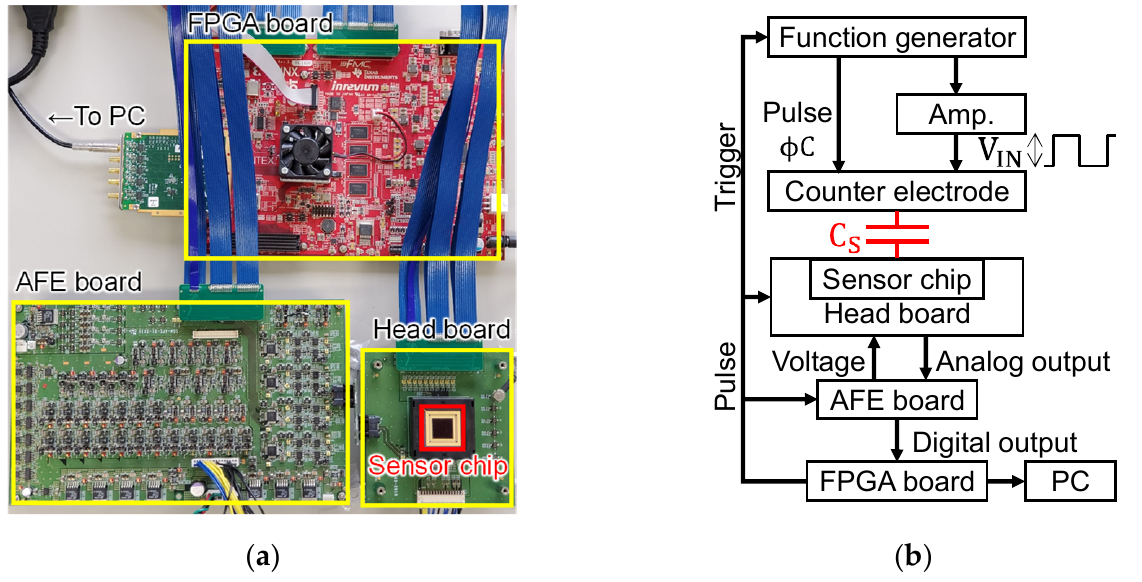
Figure 7. The measurement system for characterizing the performance of fabricated sensor chips: ( a ) picture; ( b ) block diagram.